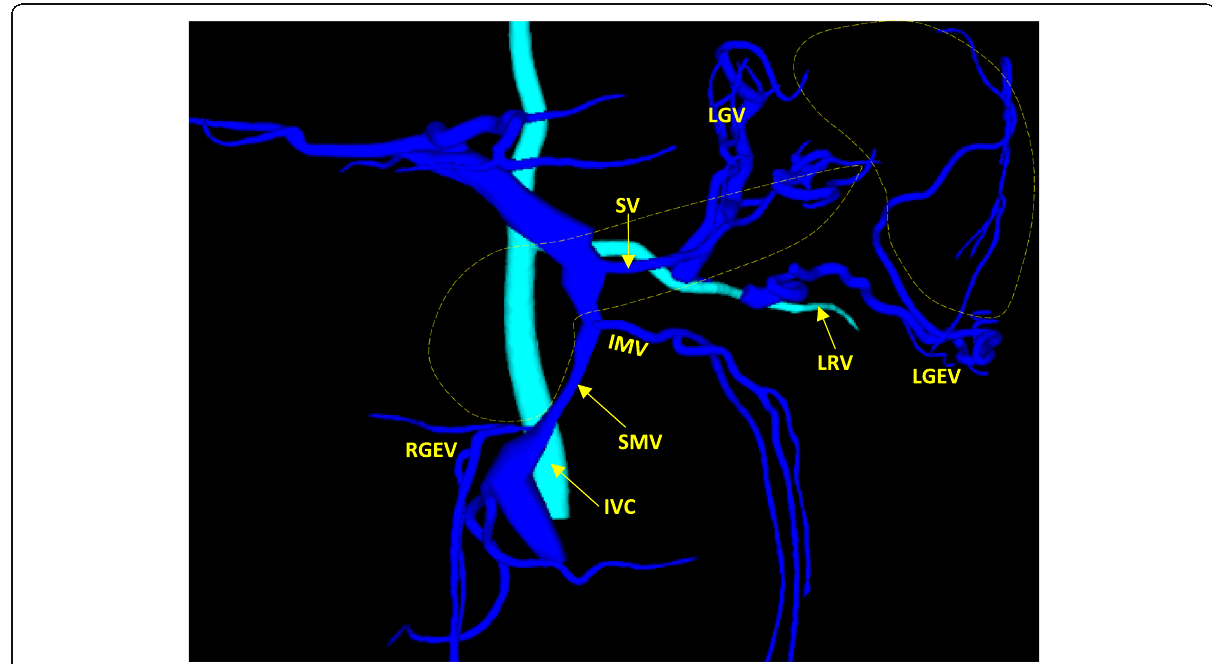
Fig. 3 3D-CT. Development of collateral veins was observed due to stenosis of the superior mesenteric vein and the splenic vein. Collateral veins of the left gastroepiploic veins and left gastric veins were partially connected to the right renal